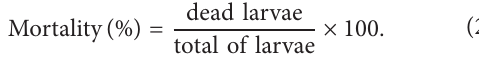
Figure 2: Regression line of probit mortality of R. ( B. ) microplus against the log concentrations of the extract of Atropa belladonna using adult immersion